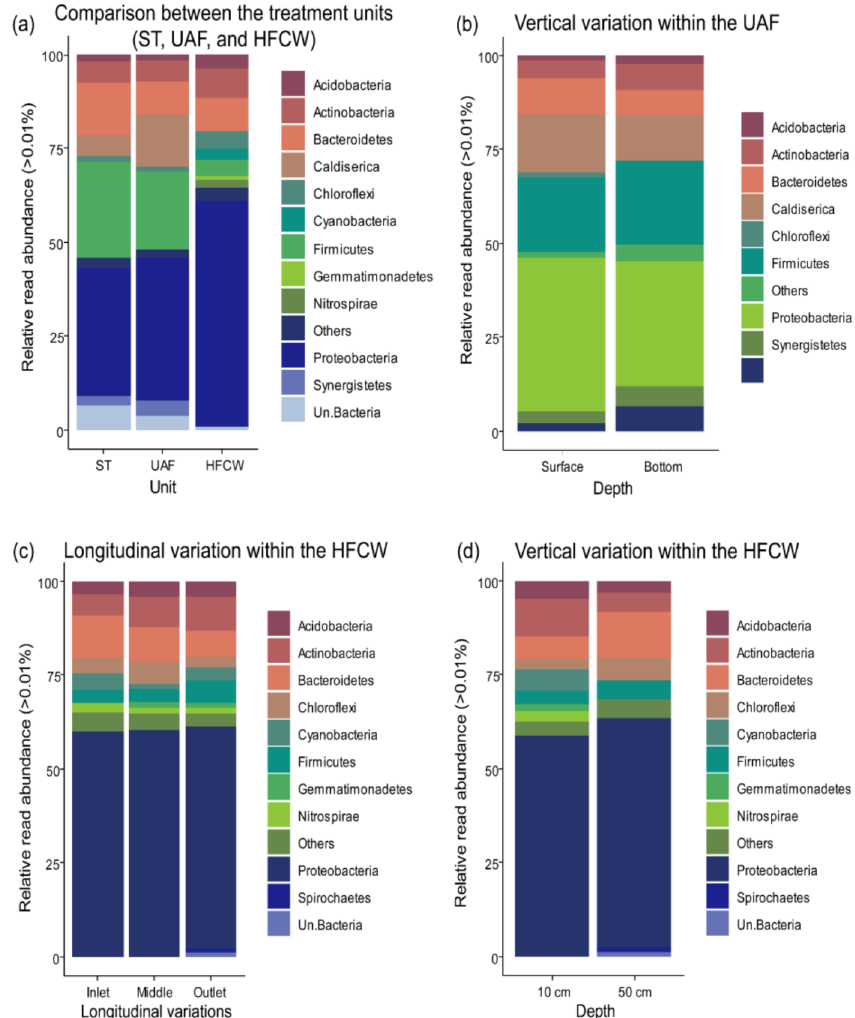
Figure 4. Phylum level taxonomic classification of bacterial sequences, Others refers to bacteria with relative read abundances < 1%, ( a ) Comparison between the treatment units (ST, UAF, and HFCW), ( b ) Vertical variation within the UAF, ( c ) Longitudinal variation within the HFCW, and ( d ) Vertical variation within the